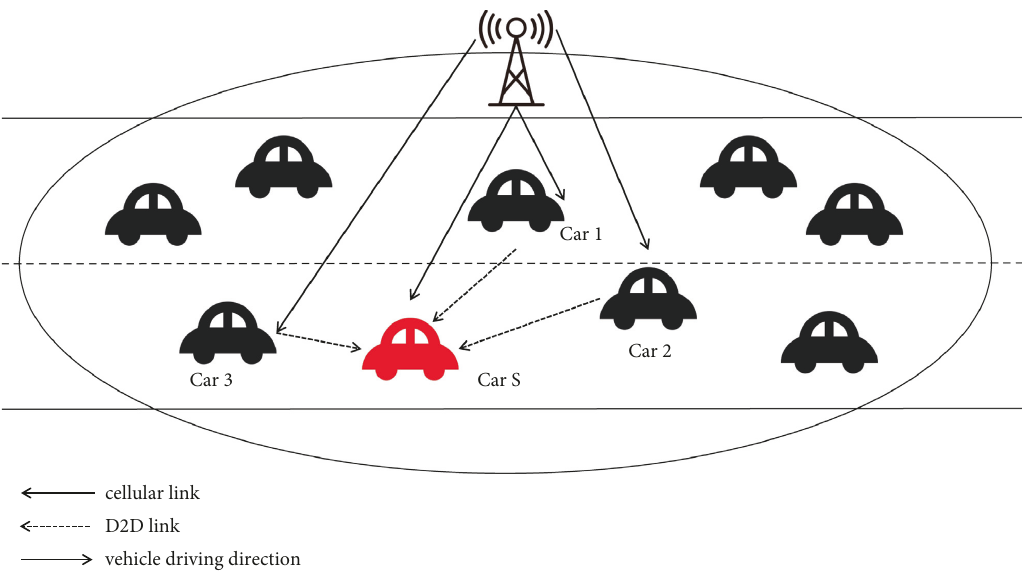
Figure 3: The model of the